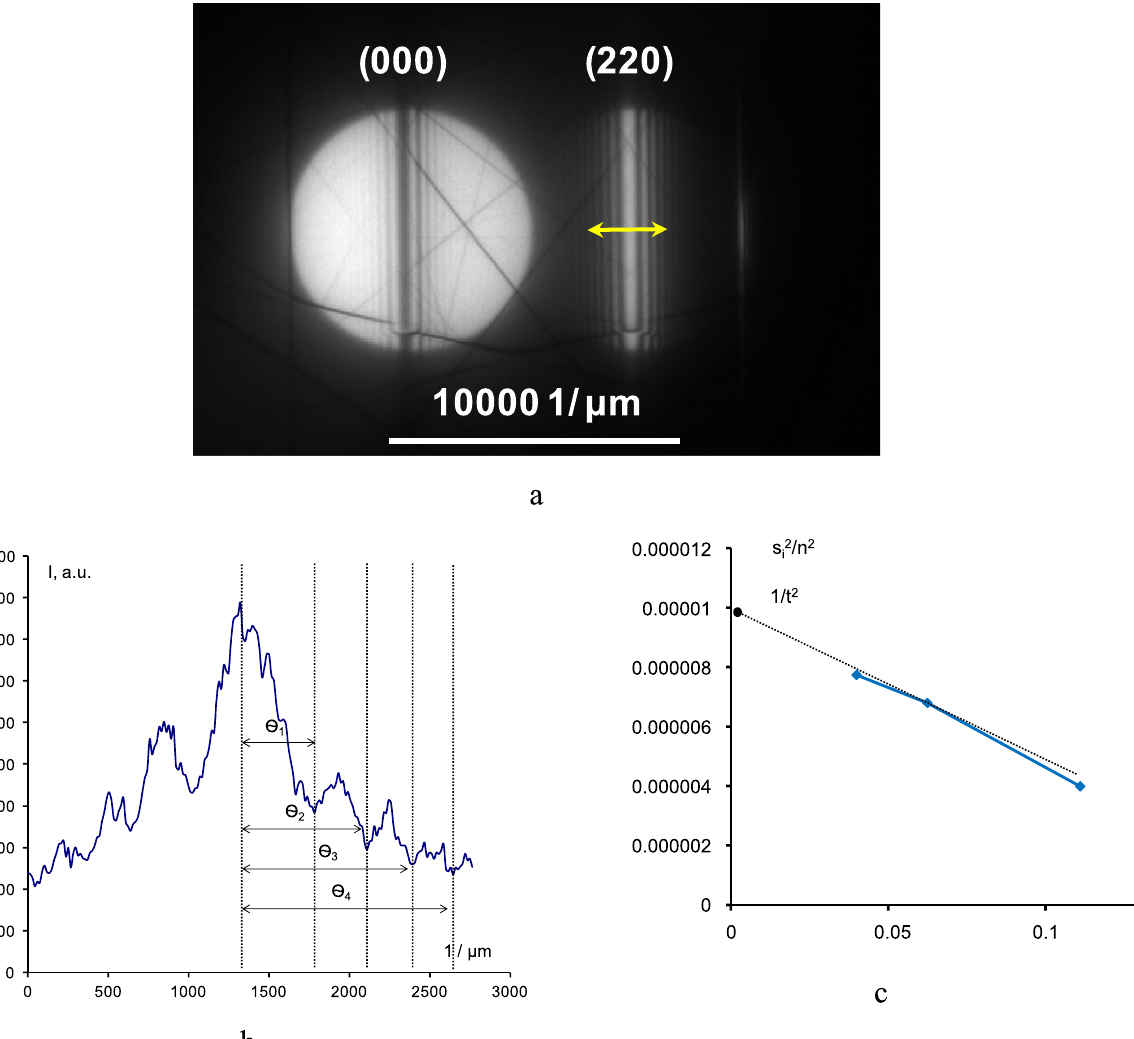
Figure 5. The CBED pattern of diamond area adjacent to the metal–diamond interface ( a ); the intensity profile of (220) CBED disk for the area shown with a yellow arrow ( b ); and the diagram showing (s i /n i ) 2 versus (1/n) 2 for calculating the sample thickness t ( c ).